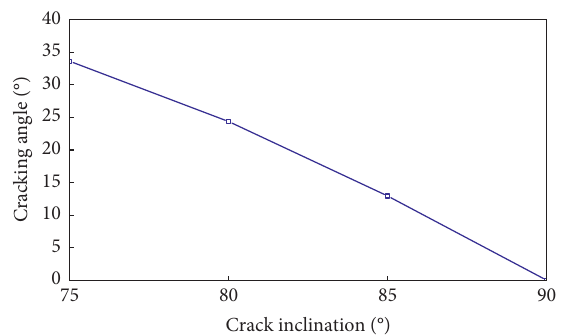
Figure 12: Relation between crack inclination and initiation angle.